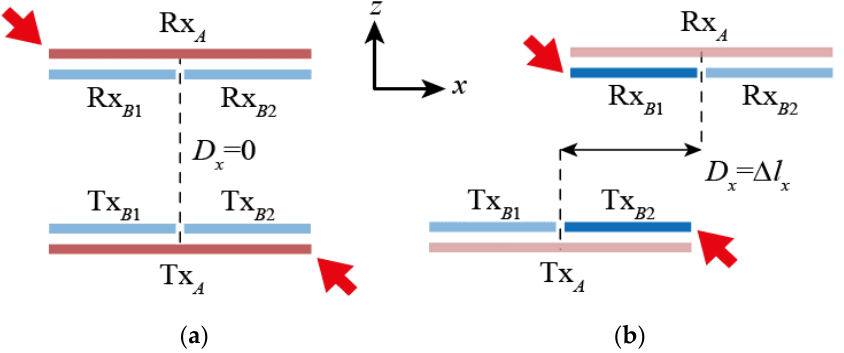
Figure 3. Operation of the multilayer coil system: ( a ) when well-aligned or with small misalignment; or ( b ) with large misalignment. Arrows indicate operating coils.